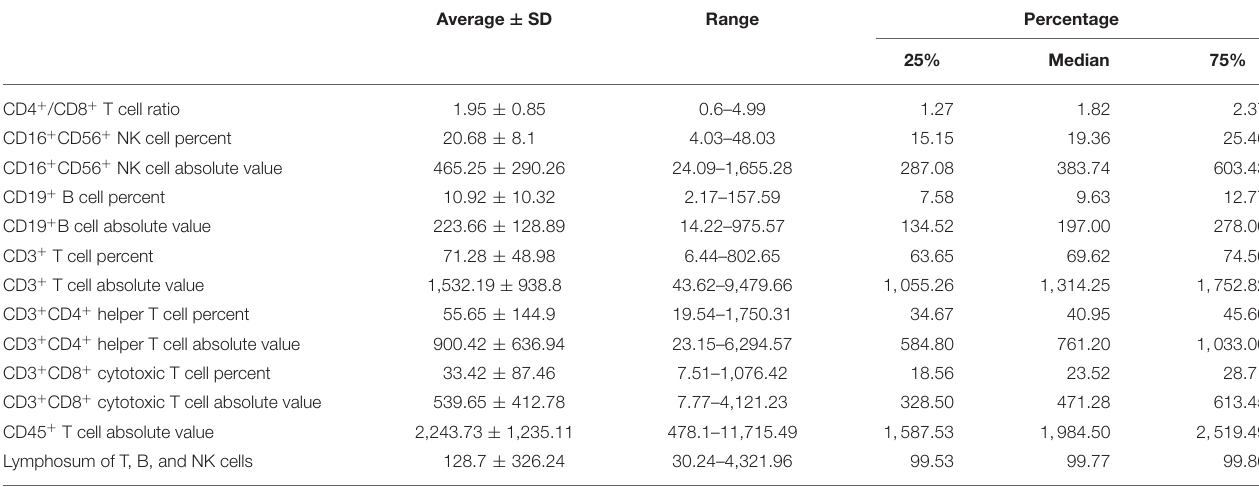
TABLE 2 | Statistical distribution of immune function indexes before NAC.